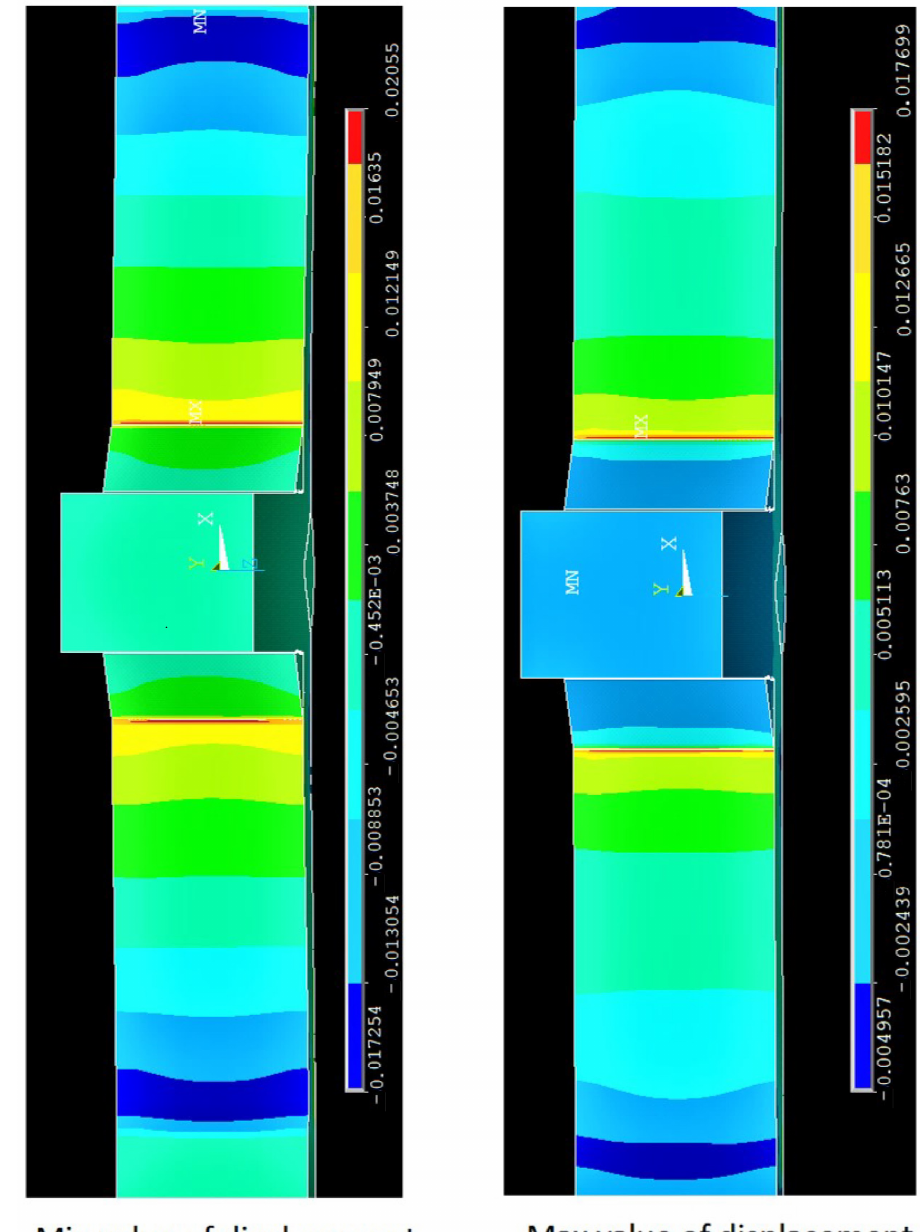
Figure 14. FE longitudinal strain map; (d a = ± 0.45 mm, R d = − 1). (( Left ) min value of displacement; ( Right ) max value of